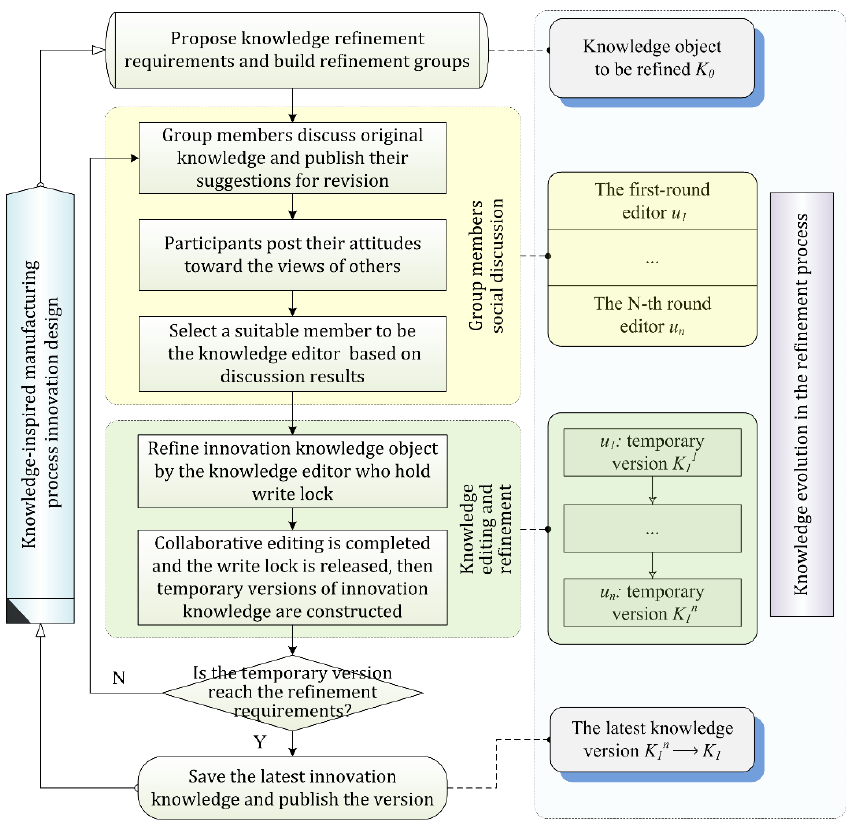
Figure 4. Procedure of collaborative knowledge refinement in an open knowledge – social community.